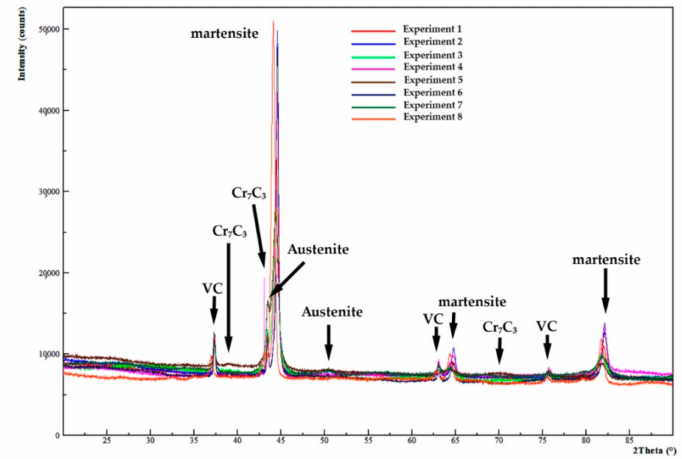
Figure 2. Di ff ractograms obtained by X-ray di ff raction (XRD).